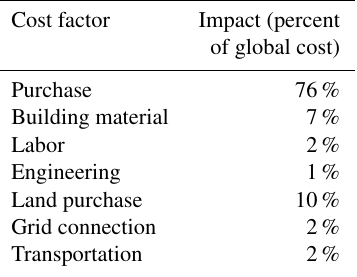
Table 3. Impact of different cost factors on a SWT